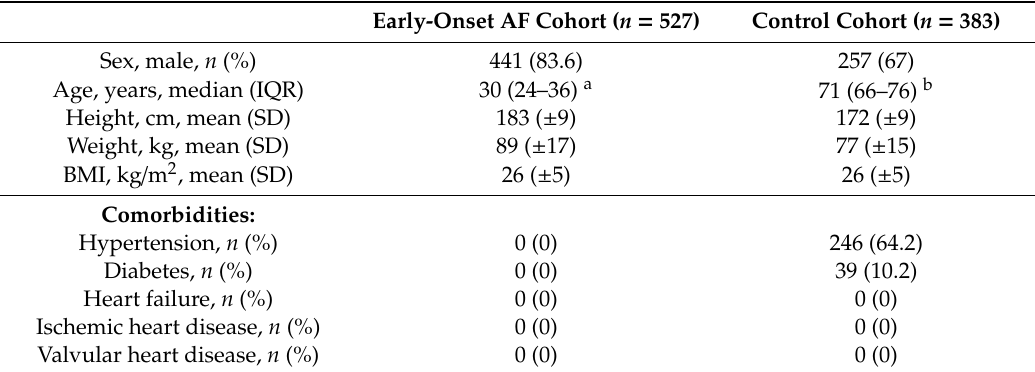
Table 1. Clinical characteristics of populations.